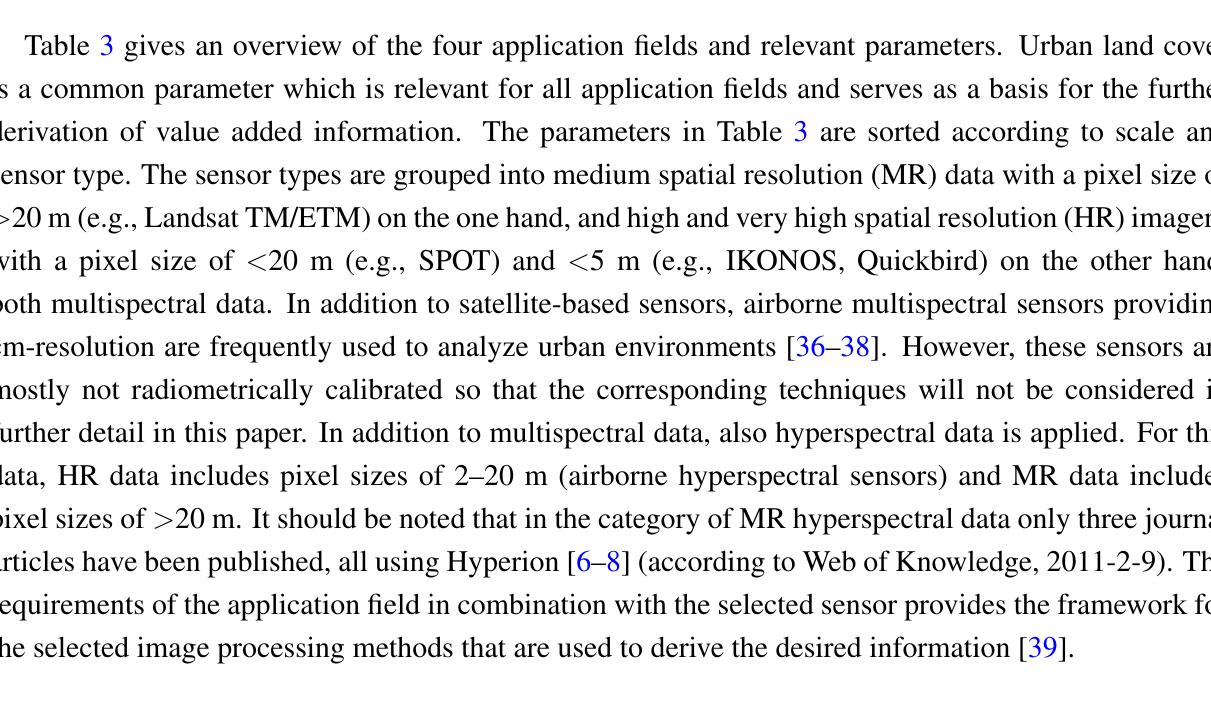
Table 3. Dominant application fields and relevant parameters with respect to the different scales and sensor